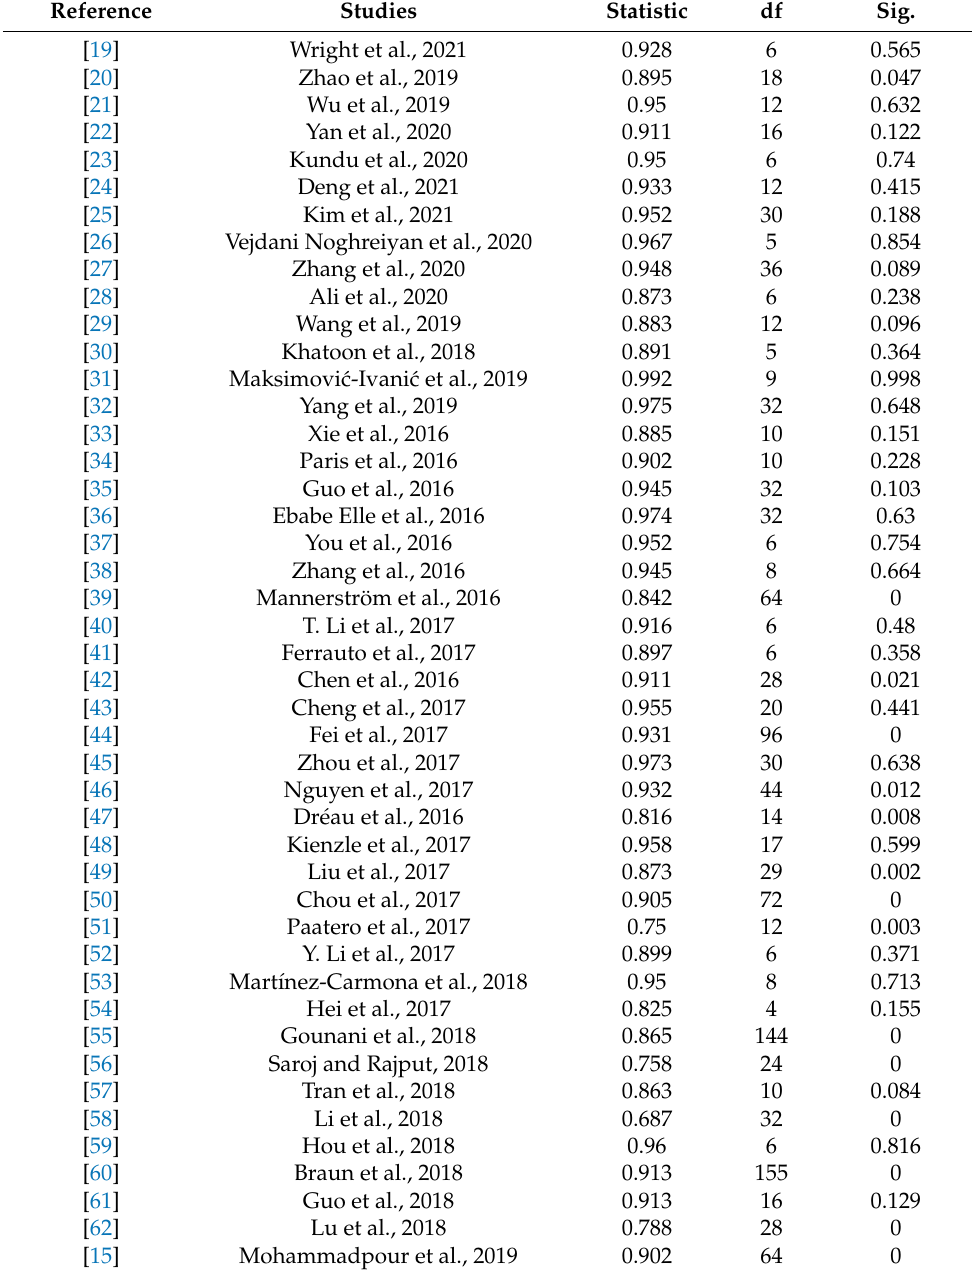
Table 1. Shapiro Wilk’s Test of Normality for each study in the